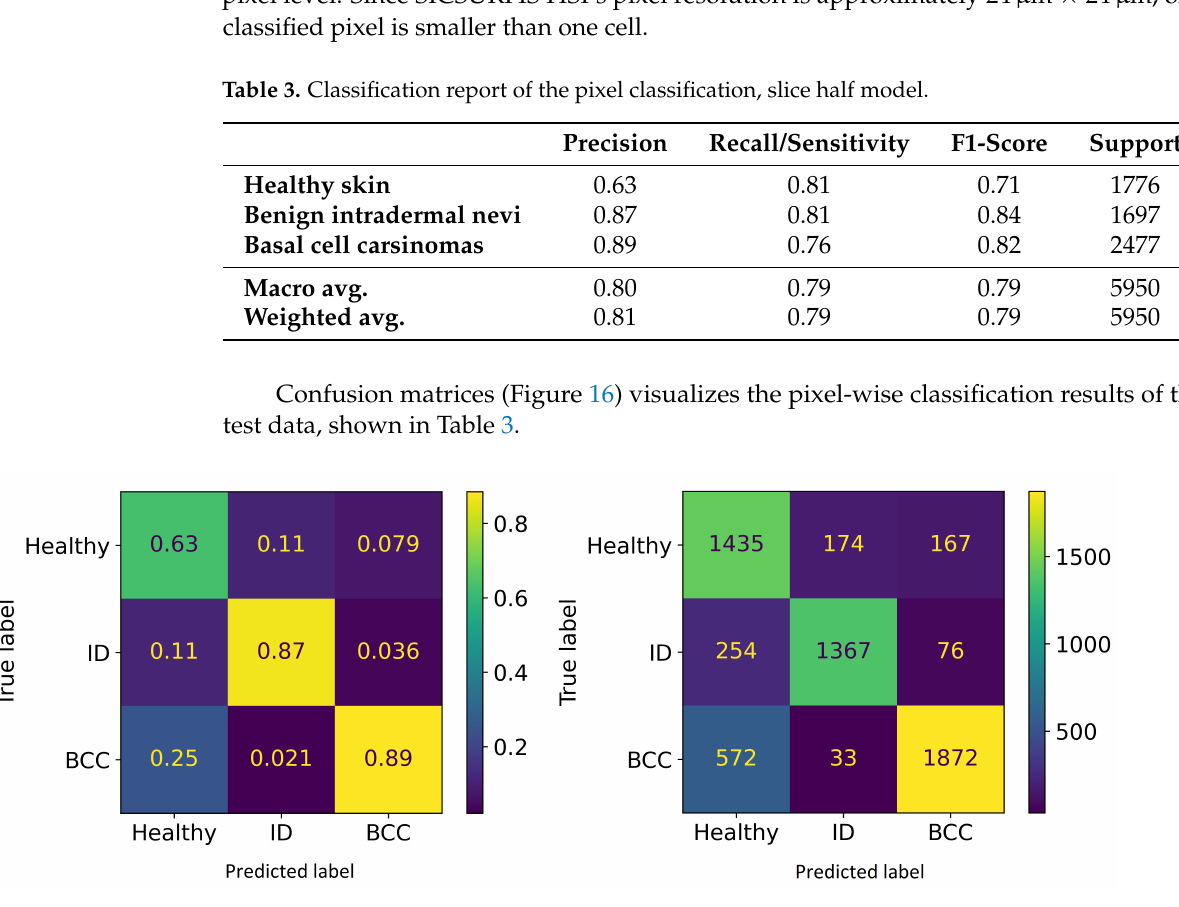
Figure 16. Confusion matrices. Left : Normalised predictions, Right :